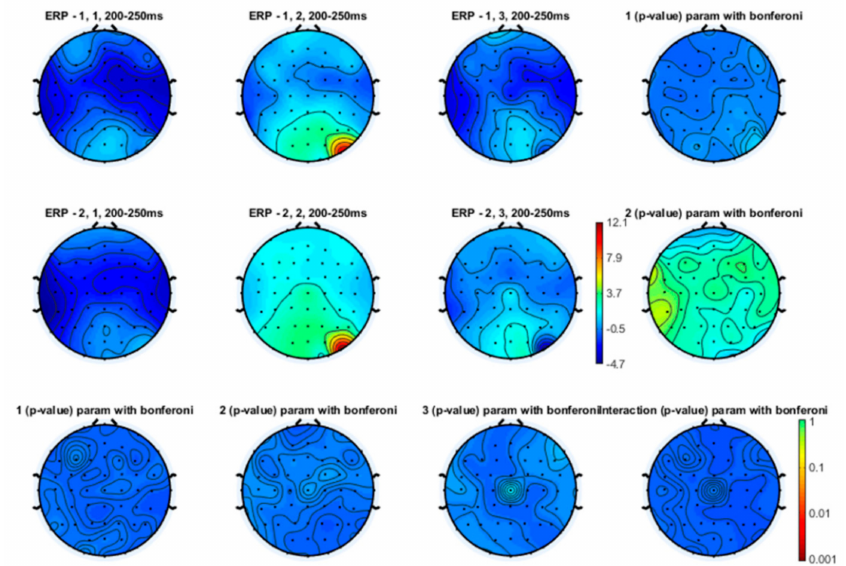
Figure 10. Topographical representation of the N2 component on the left hand stimulation. The first line of topographical maps represents the N2 amplitude in the baseline condition, slow finger tapping (SFT) and fast finger tapping (FFT) in the control group. The second line of maps represents the N2 amplitude in the baseline condition, slow finger tapping (SFT) and fast finger tapping (FFT) in the patient group. The control group’s basal condition (1,1), slow finger tapping (1,2) and fast finger tapping (1,3); the fibromyalgia (FM) group’s basal condition (2,1), slow finger tapping (2,2) and fast finger tapping (2,3) (see also Figure 1). The results of the repeated measures analysis of variance (ANOVA) corrected with the Bonferroni test are reported.